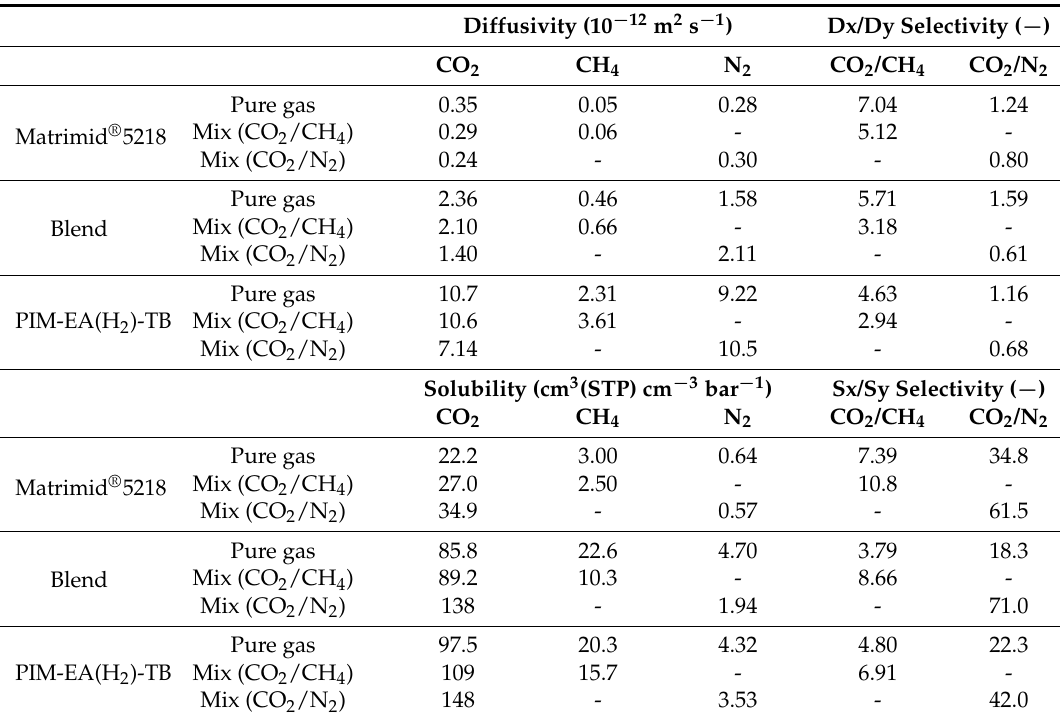
Table 3. Comparison of the pure and mixed gas diffusivity and solubility of the neat Matrimid ® 5218, PIM-EA(H 2 )-TB, and their blend membrane as measured in the mixed gas setup. Feed gas: binary mixture CO 2 /CH 4 (35/65 vol %) and binary mixture CO 2 /N 2 (15/85 vol %) at 1